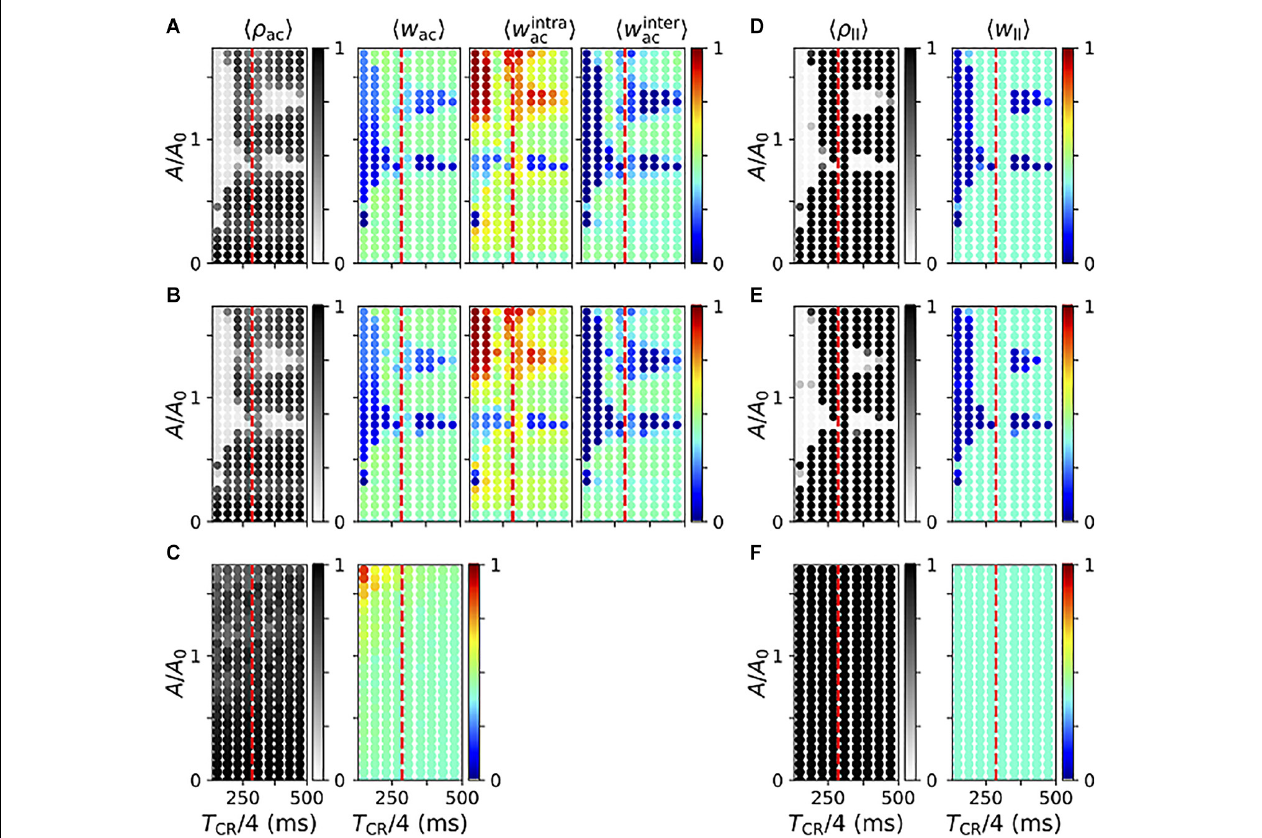
FIGURE 11 | Parameter dependence of stimulation-induced desynchronization and weight dynamics in the neuronal network model. (A–C) Acute effects of regular vibrotactile coordinated reset (vCR) (A) , noisy vCR (B) , and vibratory purely periodic multichannel stimulation (vPPMS) (C) . Columns show results for the acute Kuramoto order parameter ρ ac evaluated shortly before stimulation ceases (first column); the corresponding mean synaptic weight w ac (second column); and mean weights of intrapopulation (third column) and interpopulation synapses (fourth column), respectively. (D–F) Corresponding long-lasting effects of regular vCR (D) , noisy vCR (E) , and vPPMS (F) evaluated 1 h after cessation of stimulation. Here, the first column shows the Kuramoto order parameter ρ ll and the second column the mean synaptic weight w ll . For comparison, the mean period of the original synchronous rhythm (1 / f synch , f synch = 286 ms) is marked by vertical dashed red lines. All results were time-averaged over an interval of 12 s shortly before cessation of stimulation (A–C) and 1 h after cessation of stimulation (D–F) . Data points show ensemble averages (marked by angular brackets) over five network and sequence realizations. Results for noisy vCR were obtained using a jitter of 23.5%.